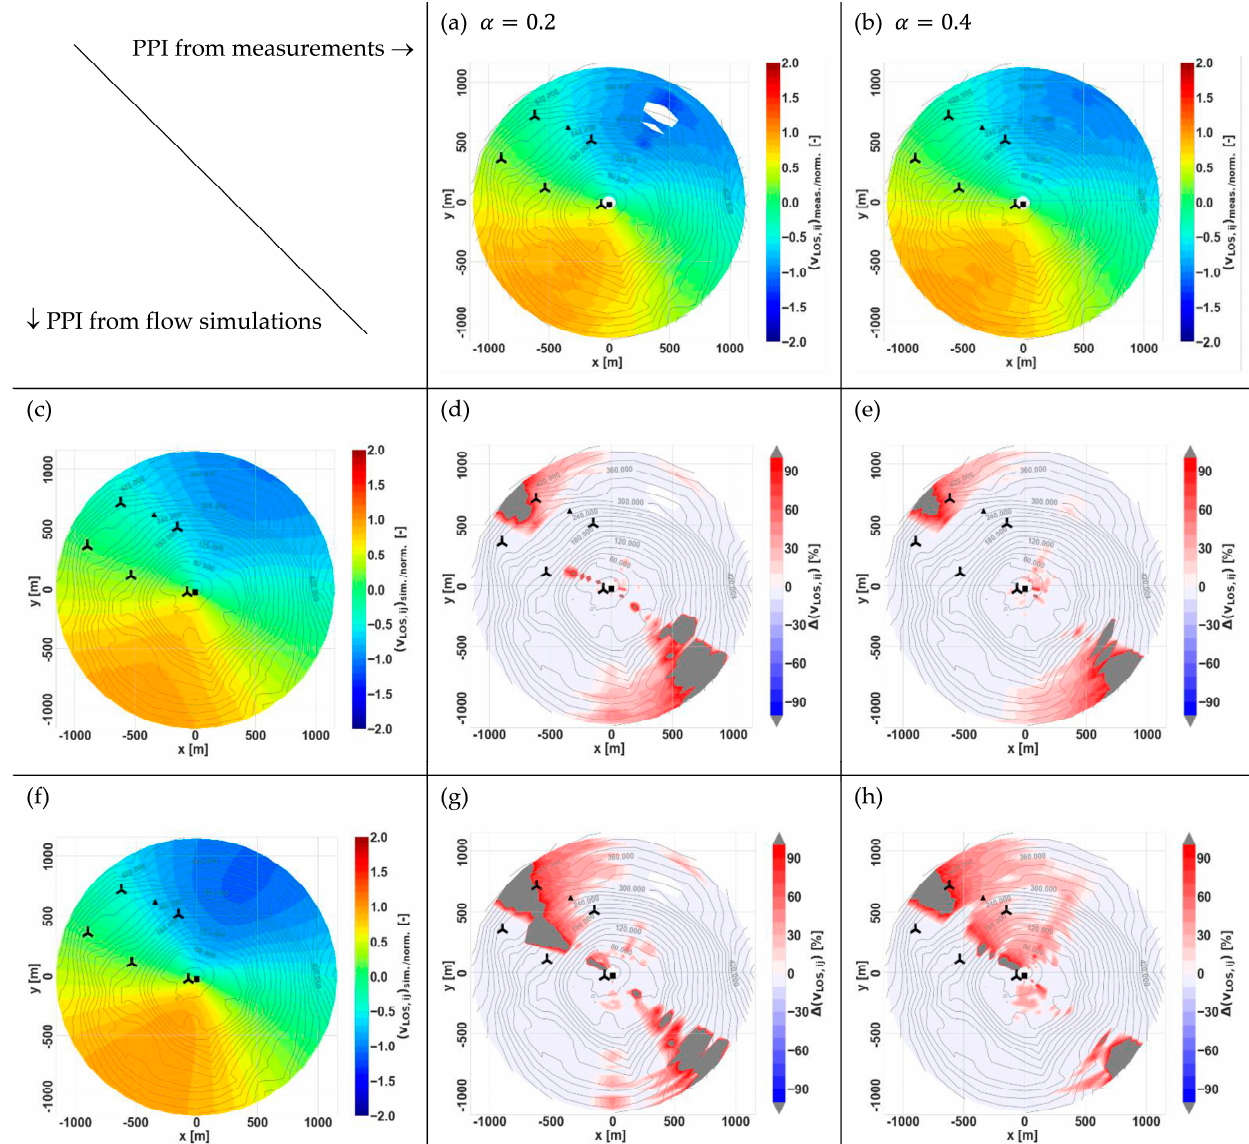
Figure 6. Measured and simulated PPI patterns, as well as corresponding deviations, for the averaged flow cases with ϕ = 210 ◦ and α = 0.2 (middle column) and α = 0.4 (right column), respectively—( a , b ) (cid:17) (cid:16) v LOS , ij lidar measurements, ( c , f ) from numerical simulations with FIWind and FITNAH, respectively, ( d , e ), sim ./ norm . ( g , h ) the corresponding deviations ( ∆ v LOS , ij ). Measurements for α = 0.2 and 0.4 were averaged from 80 and 102 individual flow situations,